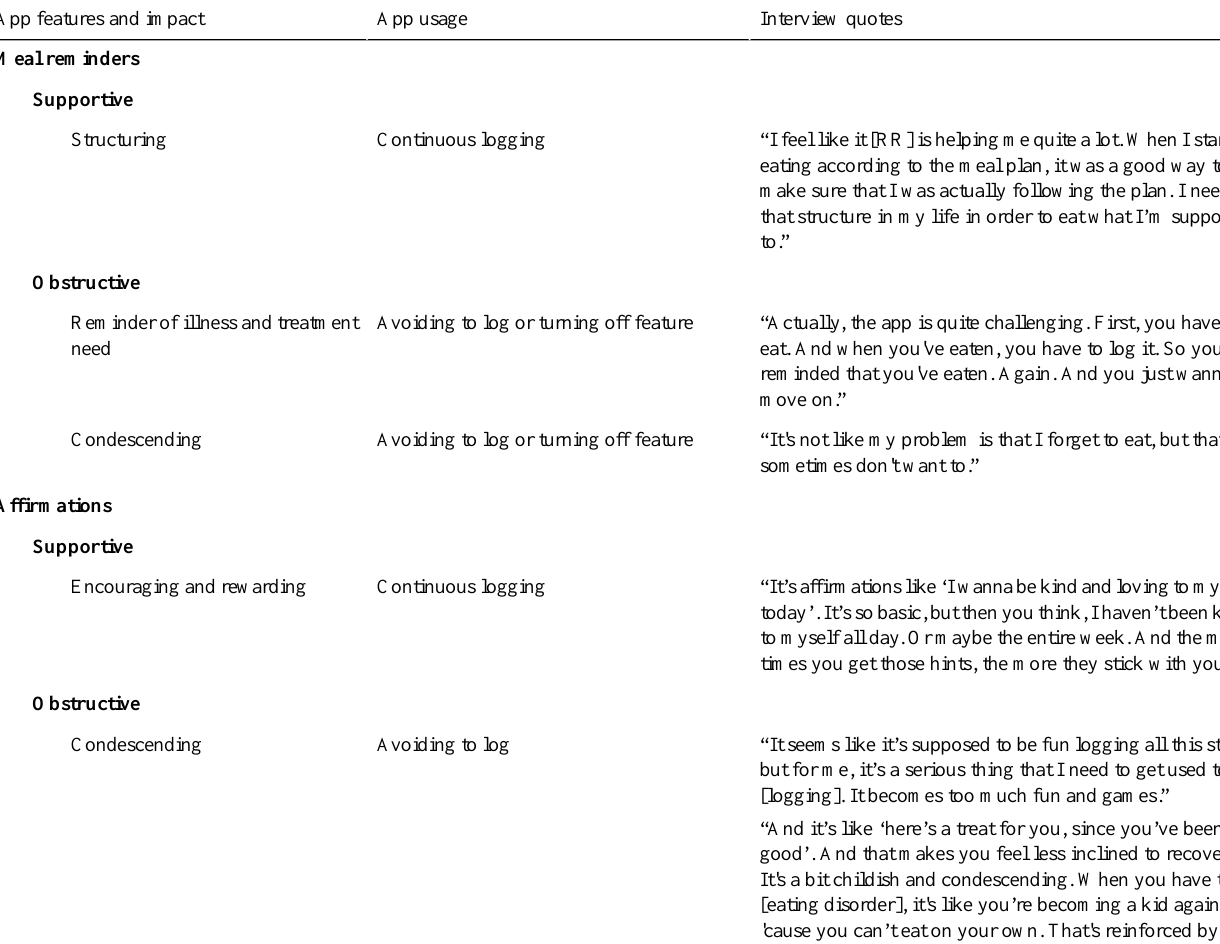
Table 5. Patients’ experiences with the nudging features of Recovery Record (RR). The table summarizes the individual patient-app interaction, that is, the specific nudging features, the impact of these on patients, and patients’specific app usage supported by interview